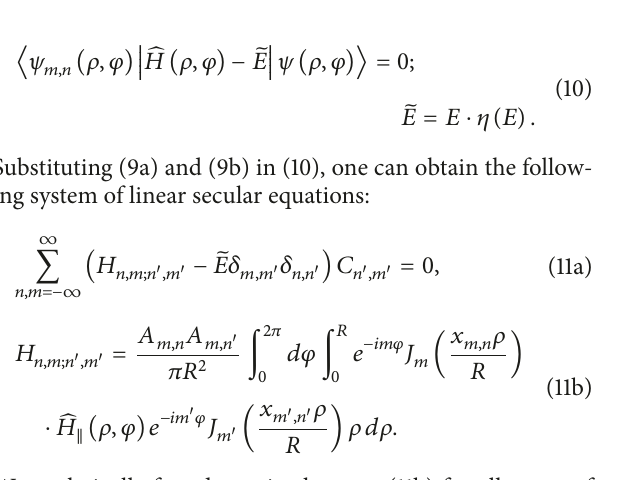
Figure 3: Energies of the on-center donor in circular QR as functions of the external magnetic field calculated in (a) in the effective mass approximation and (b) in the framework of the Kane